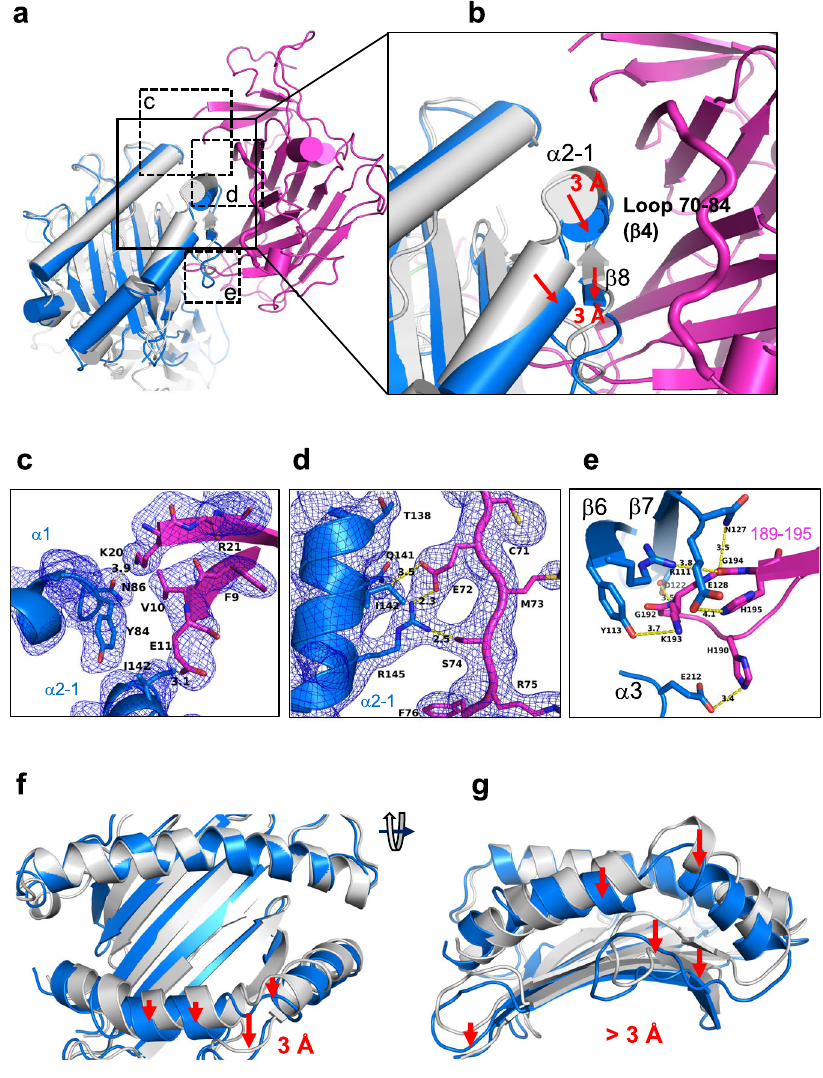
Fig.3|ComparisonofunligandedB44:05-T73C-6mer(7TUD)withthecomplex of Tapasin – B44:05 (7TUE) reveals displacement of α 2-1 helix and β -sheet fl oor of peptide binding groove of B44:05. The indicated models were superposed based on residues 54-84 of the MHC-I α chain. a – d Views of the tapasin – B44:05 interface are shown, with 1 σ 2mFo-DFc map for c , d . Letters in panel a denote the